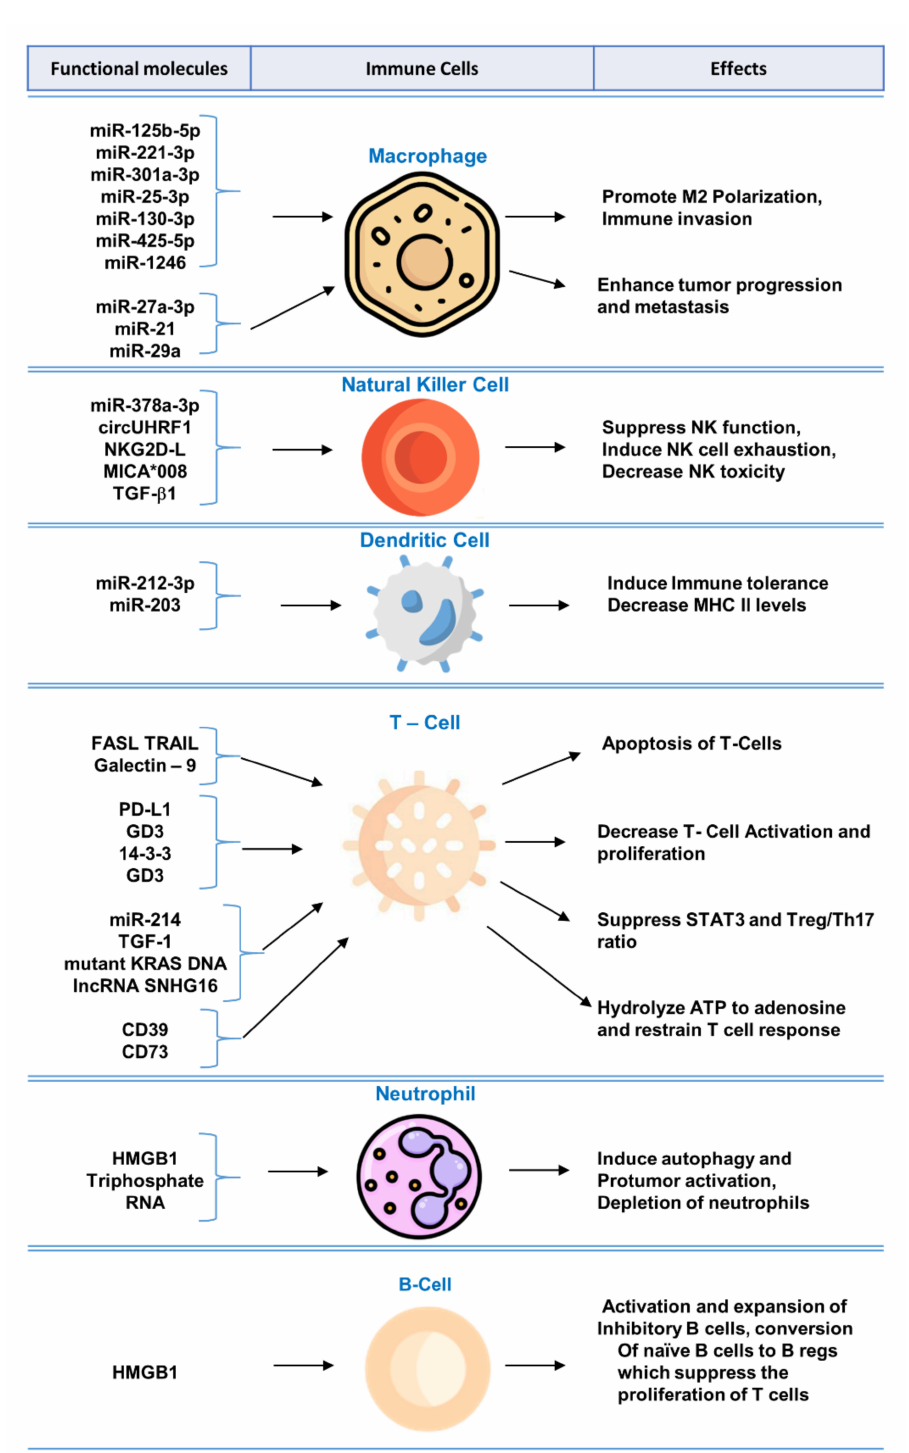
Figure 1. Functional molecules in tumor-derived exosomes for immunomodulation and exosome- mediated regulation of immune cells. 14-3-3 ζ , a family of phospho-serine binding proteins, overexpression has been linked to cancer progression and indicates poor prognosis and chemoresistance in multiple tumor types [66]. Hepatocellular carcinoma (HCC) cells have been shown to release exosomes carrying 14-3-3 ζ which were transferred to T cells infiltrating the tumor microenvironment inhibiting their antitumor effects